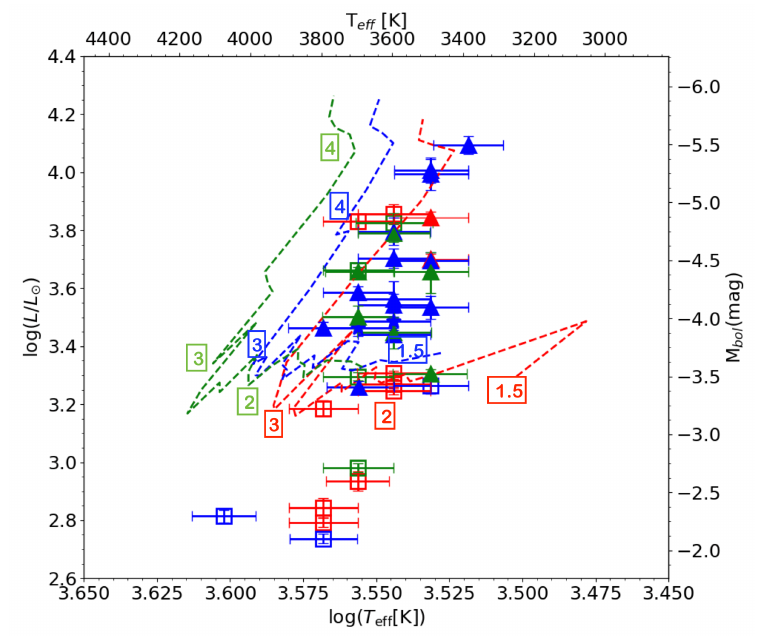
Figure 1. Hertzsprung-Russell diagram of S-type stars, using Gaia eDR3 parallaxes, from the samples of [19,20,24]. Intrinsic, Tc-rich S stars are represented with filled triangles and extrinsic, no-Tc stars by open squares. The colours separate stars in three different metallicity bins centered on [Fe/H] = − 0.5 (green), − 0.25 (blue) and 0 (red). The dashed lines connect the luminosity marking the onset of the third dredge-up events (L 3DU ) for stars of masses between 1 and 5 M (cid:12) , according to the STAREVOL evolutionary tracks [21,22], with the same metallicity colour coding as for the stars. The masses of the stars experiencing this first 3DU are indicated in the colour squares (see Figure 4 of [20] for more details). Figure adapted from